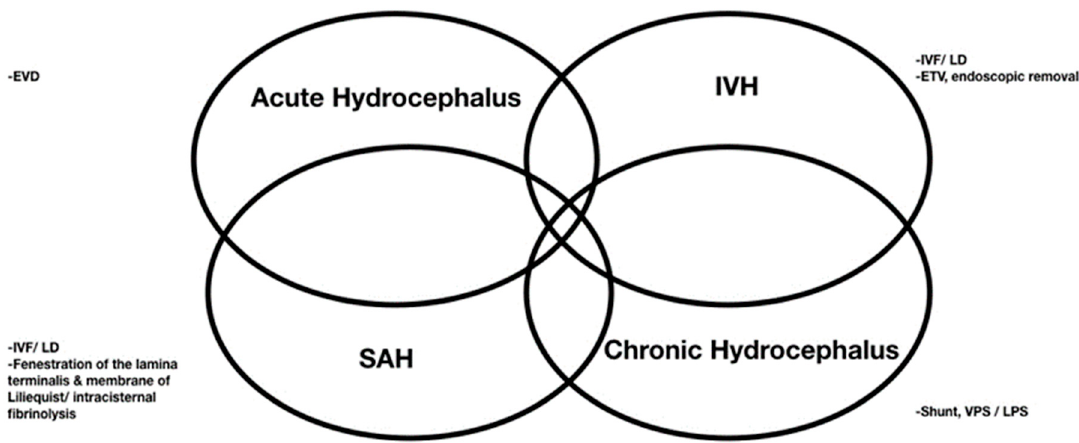
Figure 2. Surgeries applied for four mechanisms underlying the pathophysiology of aSAH-induced brain injury.